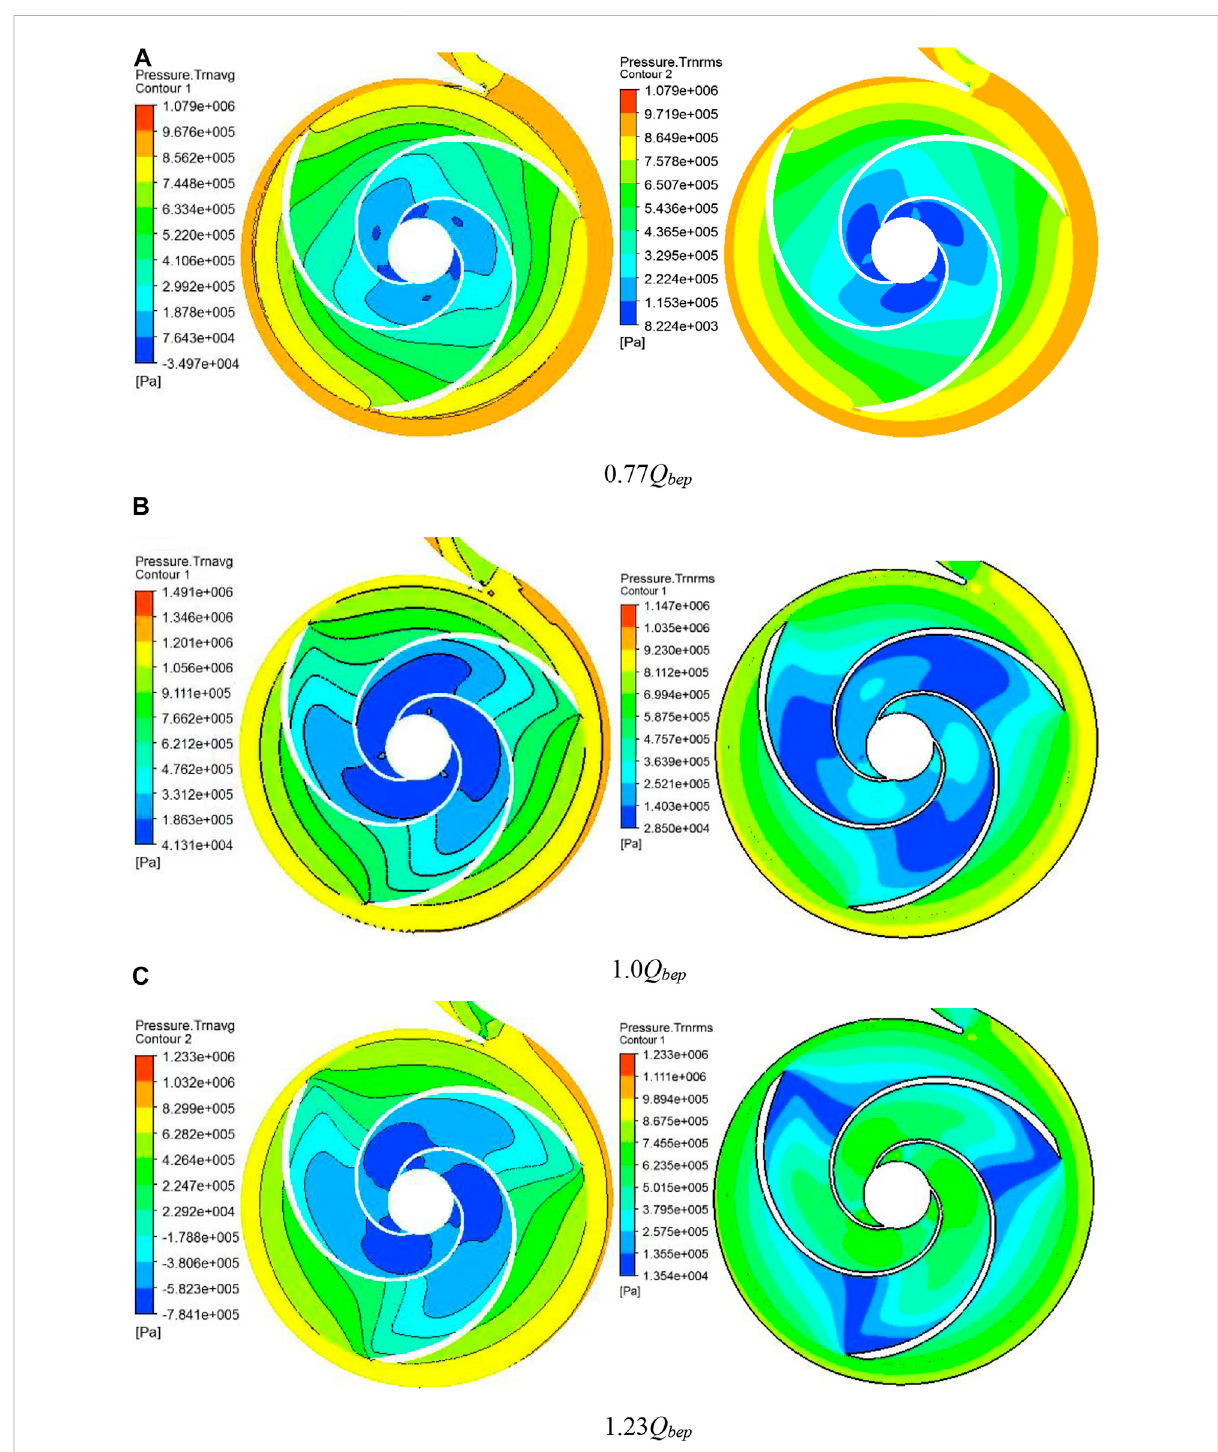
Distribution of mean pressure and pressure fl uctuation intensity in the impeller. (A) : 0.77 Qbep; (B) :1.0 Qbep; (C) : 1.23